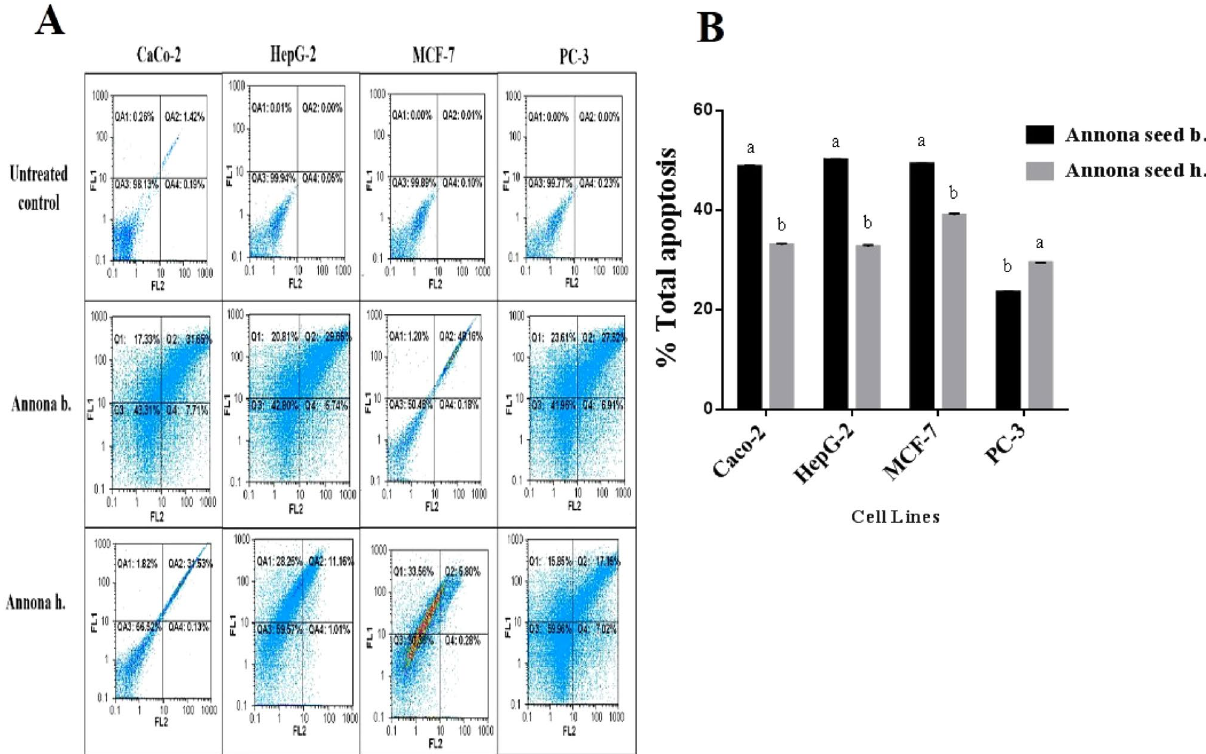
Figure 4. Quantitative detection of the apoptotic effect of seed extracts of Annona species in human cancer cell lines ( A ) Annexin V/Propidium Iodide (PI) flow cytometry charts with ( B ) histograms of total percentage of apoptotic cell populations, results are presented as mean ± SE (n = 3). Different letters for the same cell line are significantly different at p <